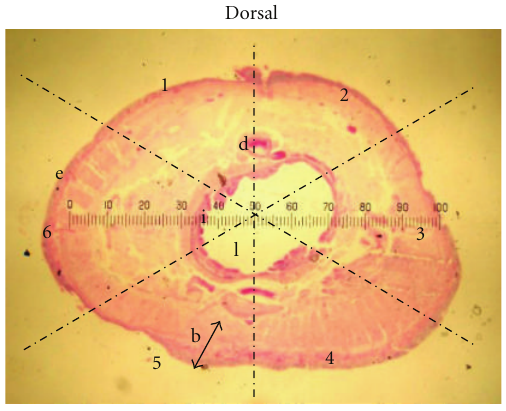
Ventral Figure 2: Earthworm mortality exposed to commercial neem ex- Figure 1: Earthworm transverse section showing the epidermis, tract containing Aza at 48 and 72 h. body wall and intestinal epithelium stained with haematoxylin and eosin ( × 10). Nos. 1–6 show the regions where the radial thickness was measured. e: epidermis; b: body wall; i: intestinal epithelium; l: Table 1: Change in coelomocyte numbers and coelomocyte via- lumen; d: dorsal blood vessel. bility of Pheretima peguana exposed to commercial neem extract (NEEM) containing Aza in a 48-h filter paper